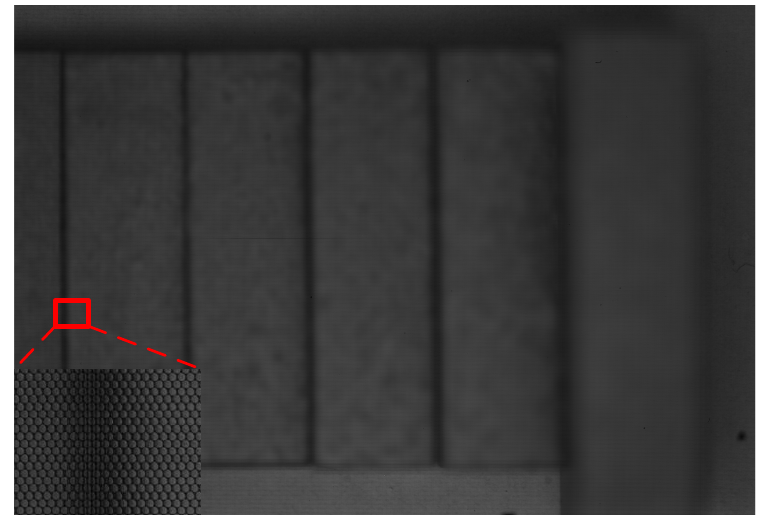
Figure 5. Raw light-field image of standard gauge blocks captured by VOMMA Optec